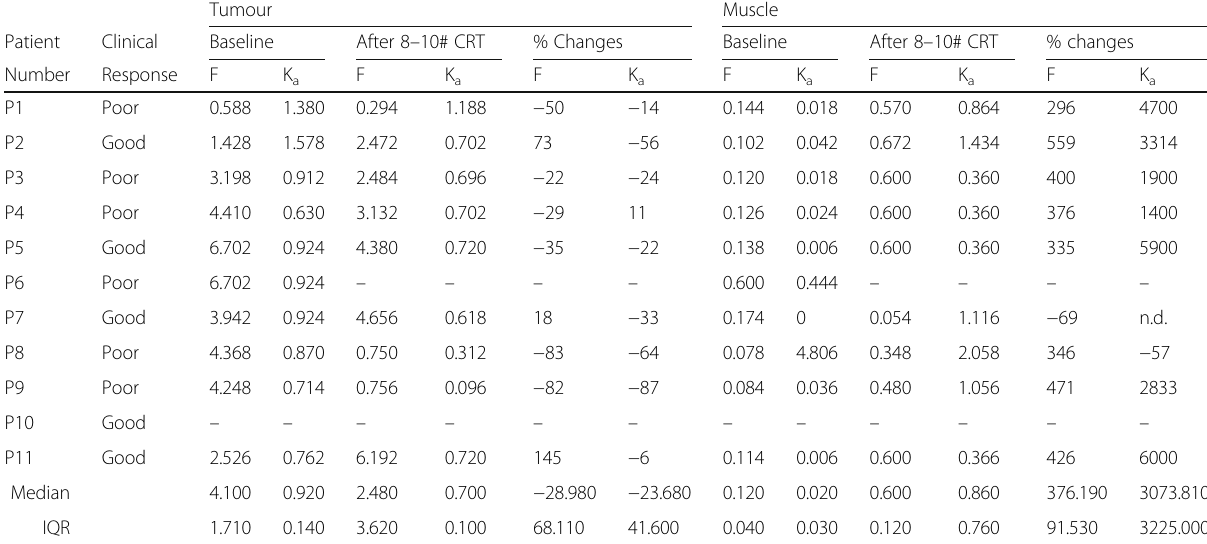
Table 4 Tumour and muscle imaging parameters representing blood perfusion ( F ) and hypoxia ( K a ) from fitting 45 min [ 18 F]FMISO PET readings to Casciari model at baseline and after 8 – 10 fractions of chemoradiotherapy (CRT). Response is as defined in Table 1 Tumour Muscle